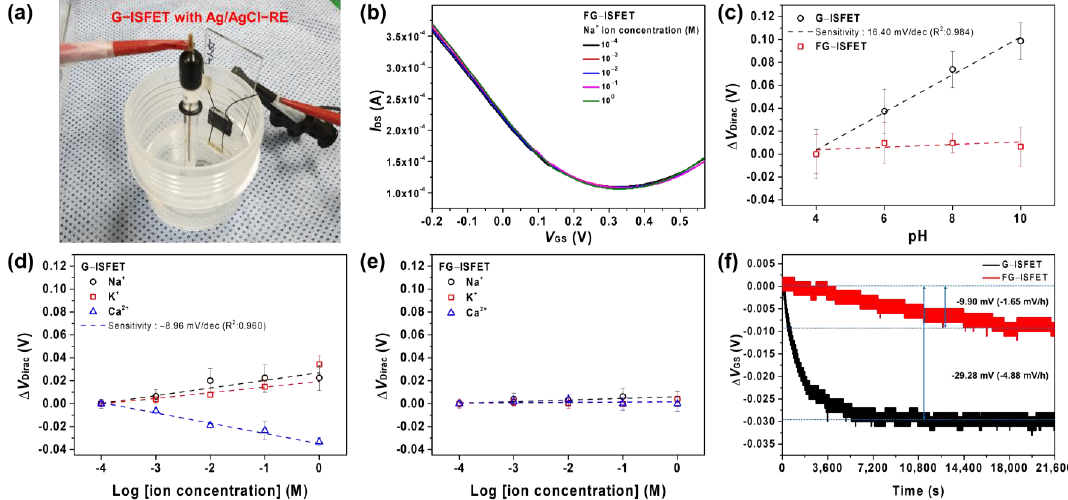
Figure 2. Evaluation of sensitivity of G–ISFET and FG–ISFET with Ag/AgCl–RE. Linear fits were used to extract sensitivity: ( a ) experimental setup using G–ISFET with Ag/AgCl–RE; ( b ) I DS – V GS of FG–ISFET depending on Na + ion concentration; ( c ) pH sensitivity of G–ISFET and FG–ISFET; ( d ) Na + , K + , and Ca 2+ sensitivity of G–ISFET; ( e ) Na + , K + , and Ca 2+ sensitivity of FG–ISFET; and ( f ) long–term stability of G–ISFET and FG–ISFET in Tris–HCl buffer, in which 100 mM NaCl was dissolved for 6 h.